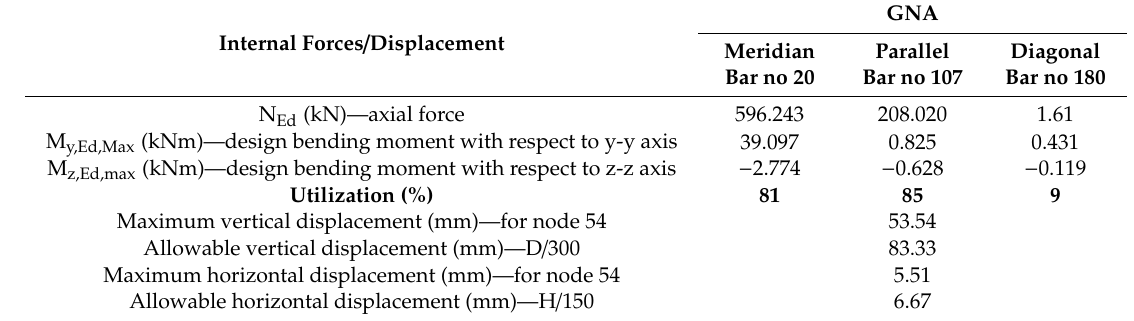
Table 10. Values of the internal forces and the maximum horizontal and vertical displacement of node 54 for GNA.